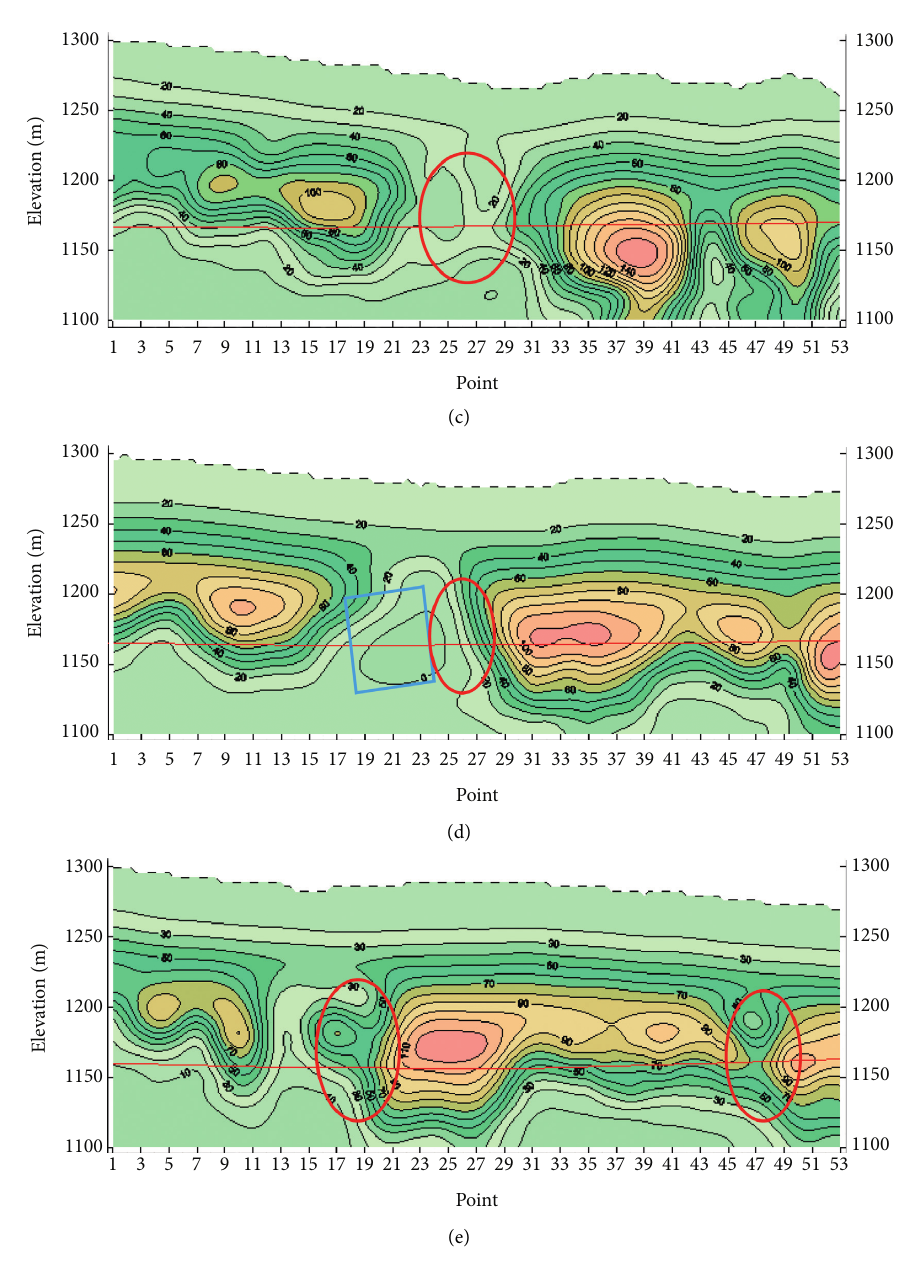
Figure 14: Cross section of apparent resistivity of each measuring line. (a) Line 5, (b) line 6, (c) line 9, (d) line 13, and (e) line